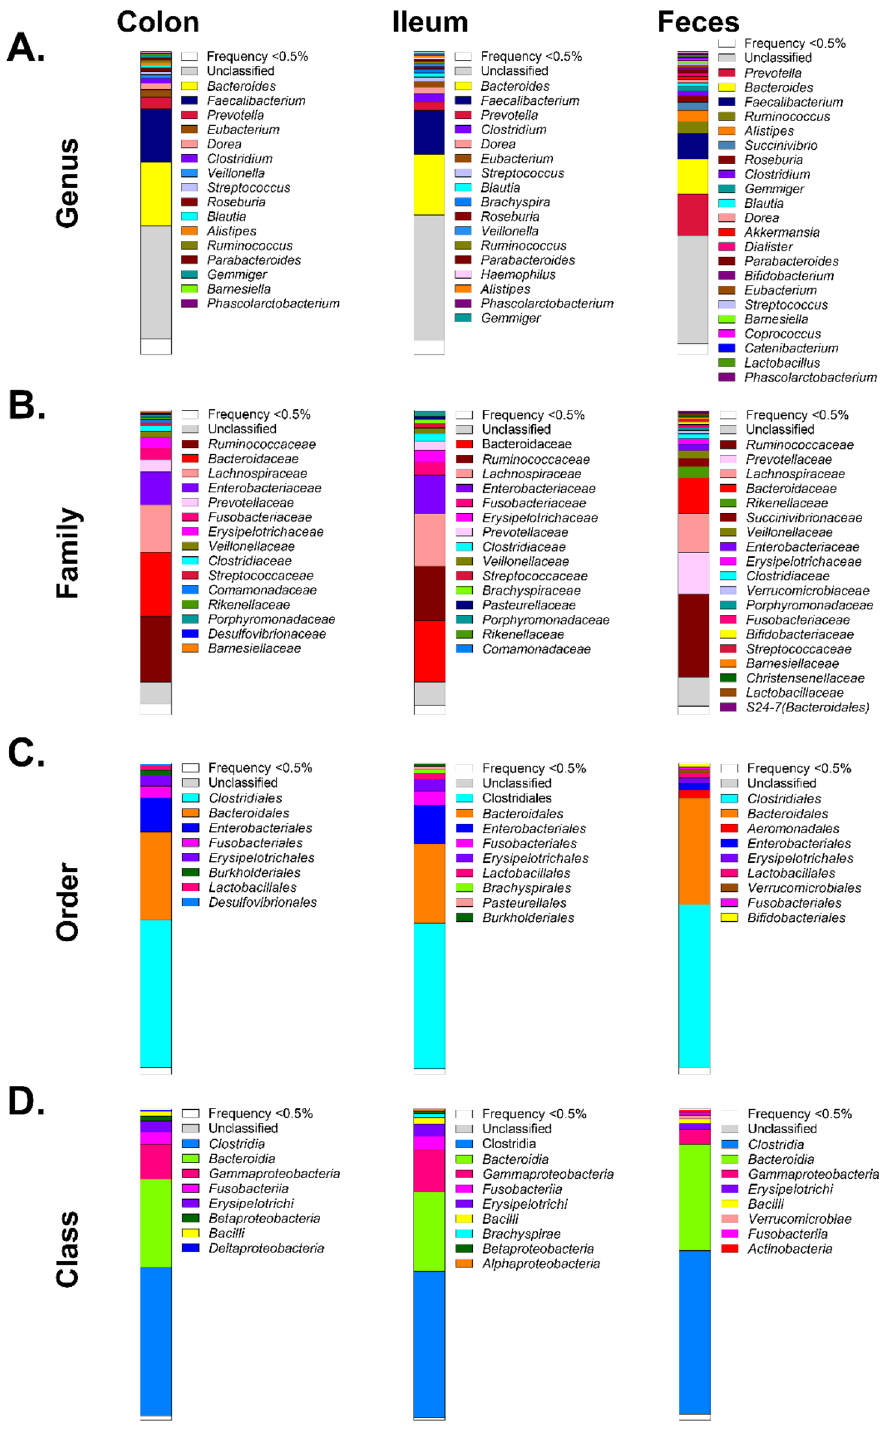
Figure 2. Taxonomic analysis for colon, ileum and feces samples. Colon and ileum exhibit a closer bacteria composition. Bars represent the average relative frequency at different taxonomic levels for each group. Genus ( A ), family ( B ), order ( C ) and class ( D ) levels are shown. Taxa with relative frequency greater than 0.5% are shown. Most abundant taxa are described on the right of each bar, starting on the top with the most abundant